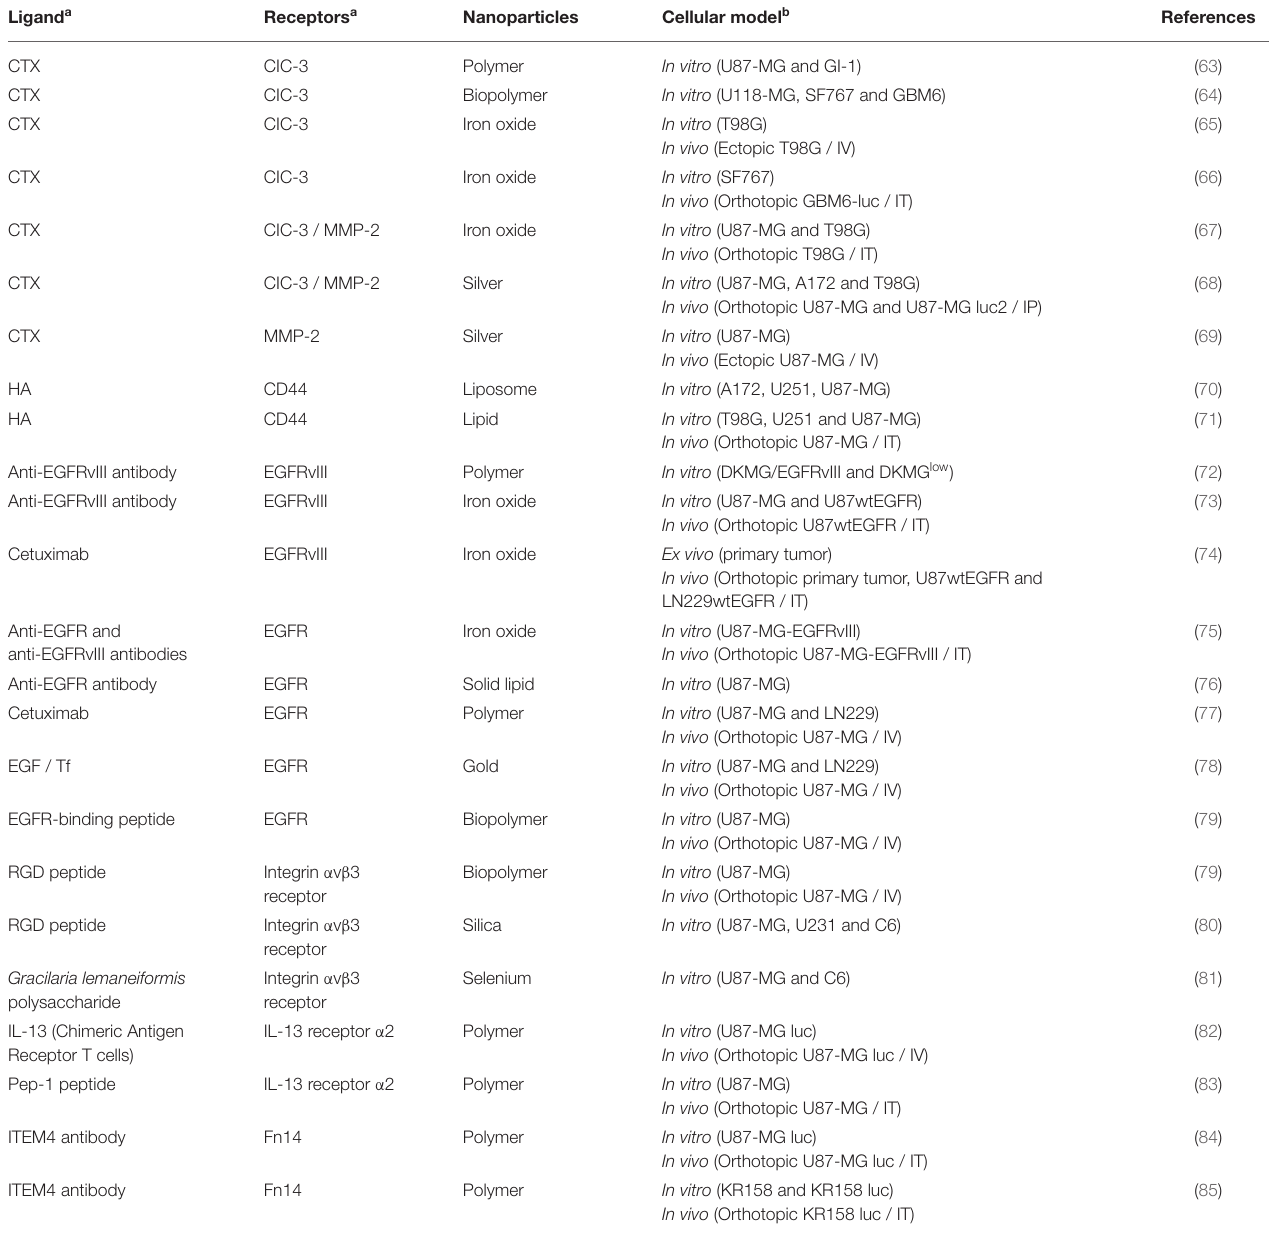
TABLE 1 | Selection of ligands for GBM cell targeting, with the corresponding